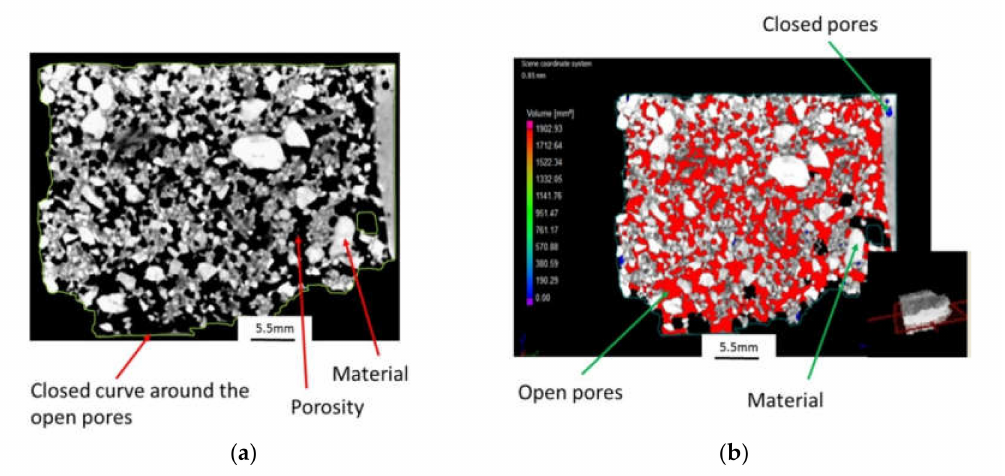
Figure 6. CT cross-sections through composite 2 of sample S1: ( a ) gray values indicate the material and porosity; ( b ) color map is used to indicate the pore volume size.